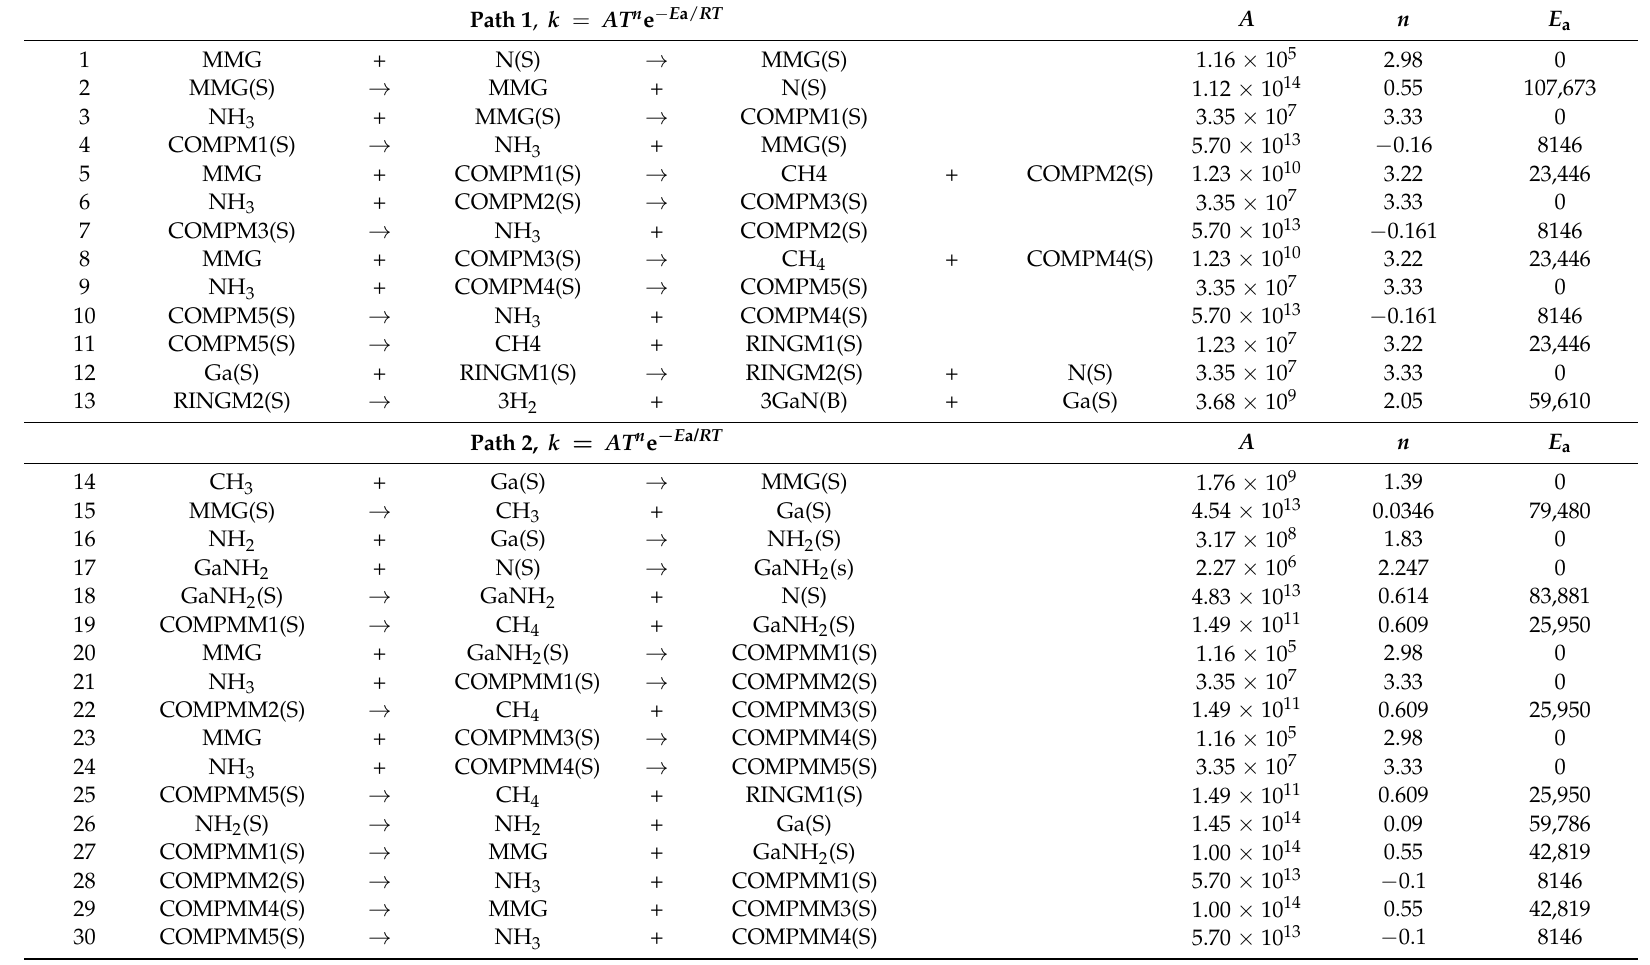
Table 2. Surface-phase mechanism of the complete model [15] (the unit of E a is